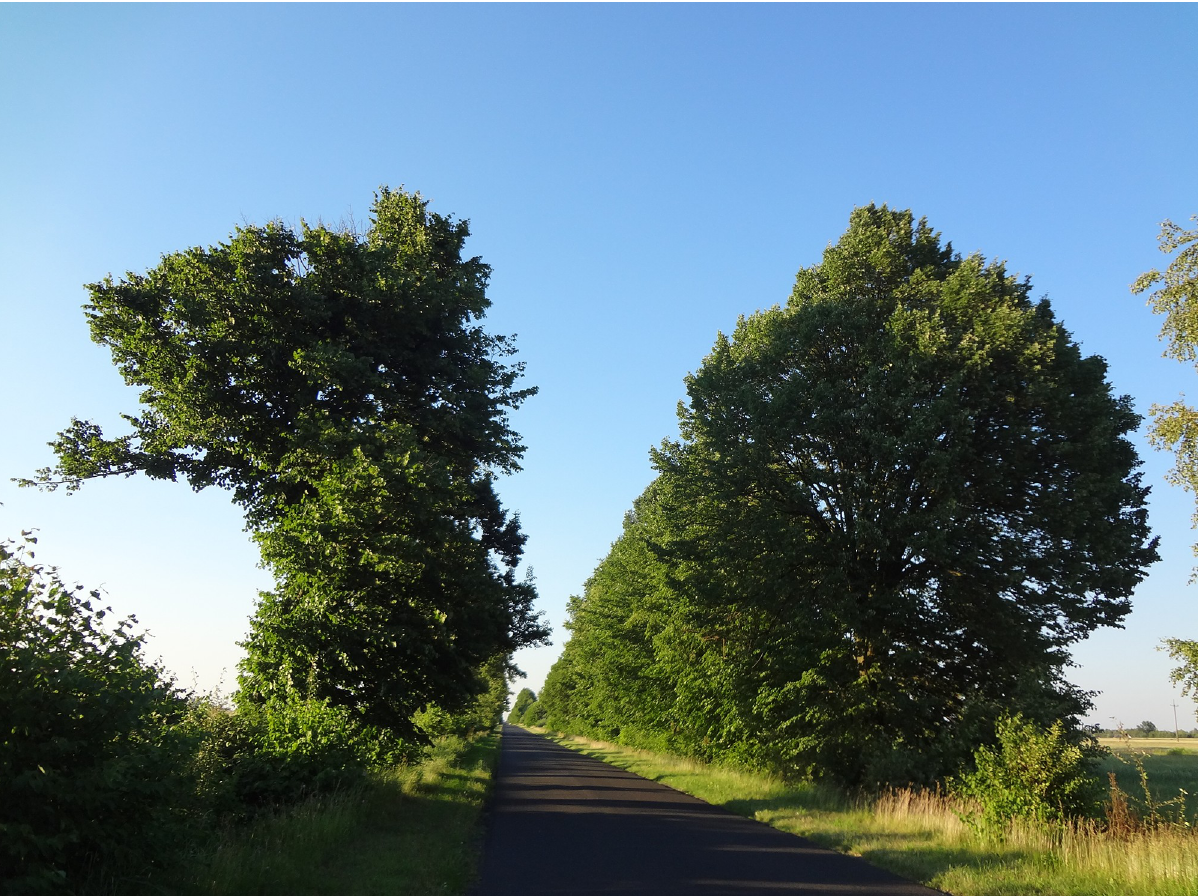
Fig 4. Crowns of damaged trees (left) and control trees (right), June 18, 2016. Photo by M.